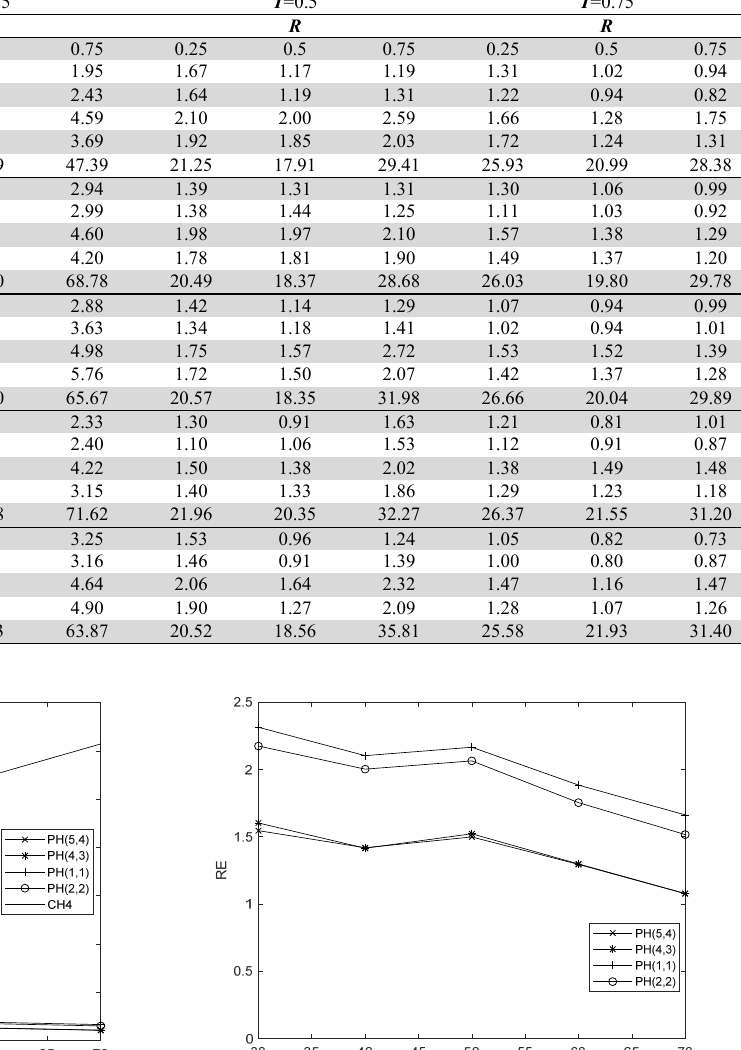
Heuristic RE ( Δ = 20)